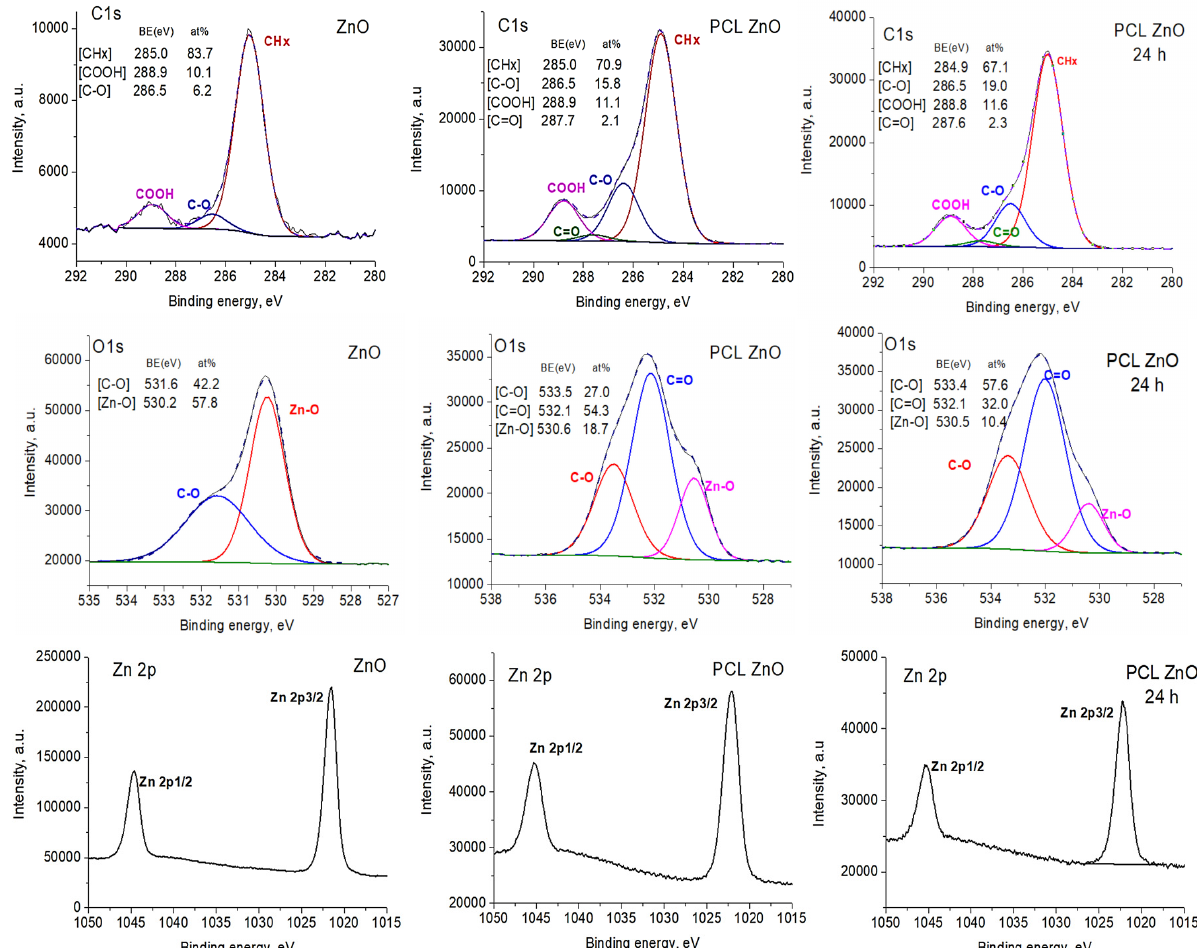
Figure 3. XPS C1s, O1s, and Zn2p spectra of samples ZnO NPs, PCL-ZnO and PCL-ZnO-24 h.